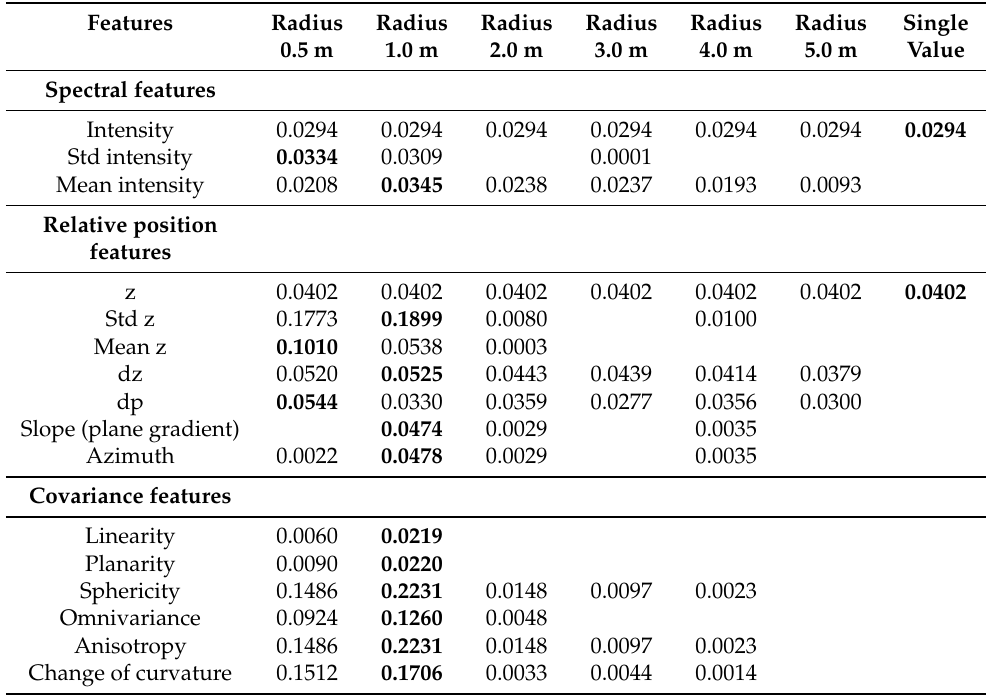
Table 3. Boulder 1 predictors with positive weight calculated from relief-F algorithm.